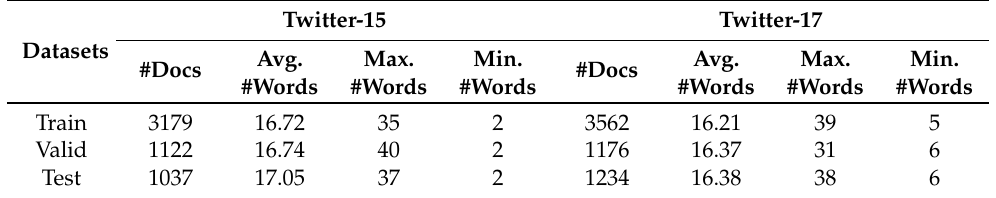
Table 6. Statistics of Twitter-15 and